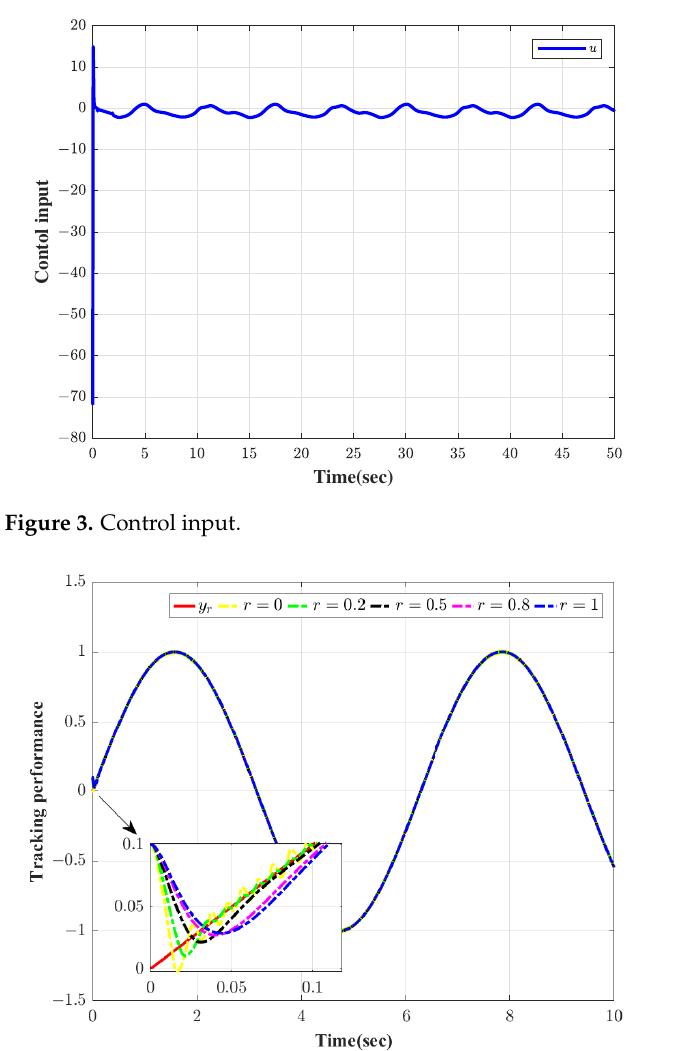
Figure 4. Tracking